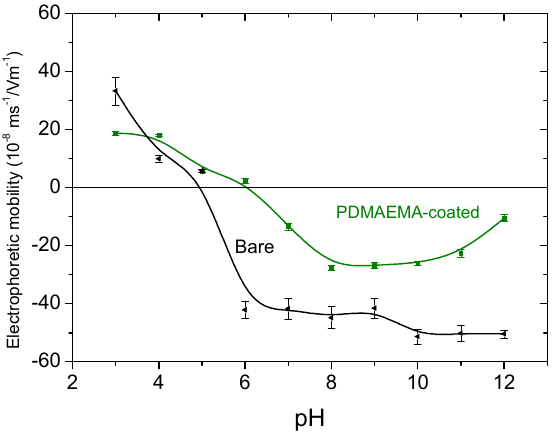
Figure 7. Effect of pH on the electrophoretic mobility of magnetite nanoparticles before and after PDMAEMA coating.